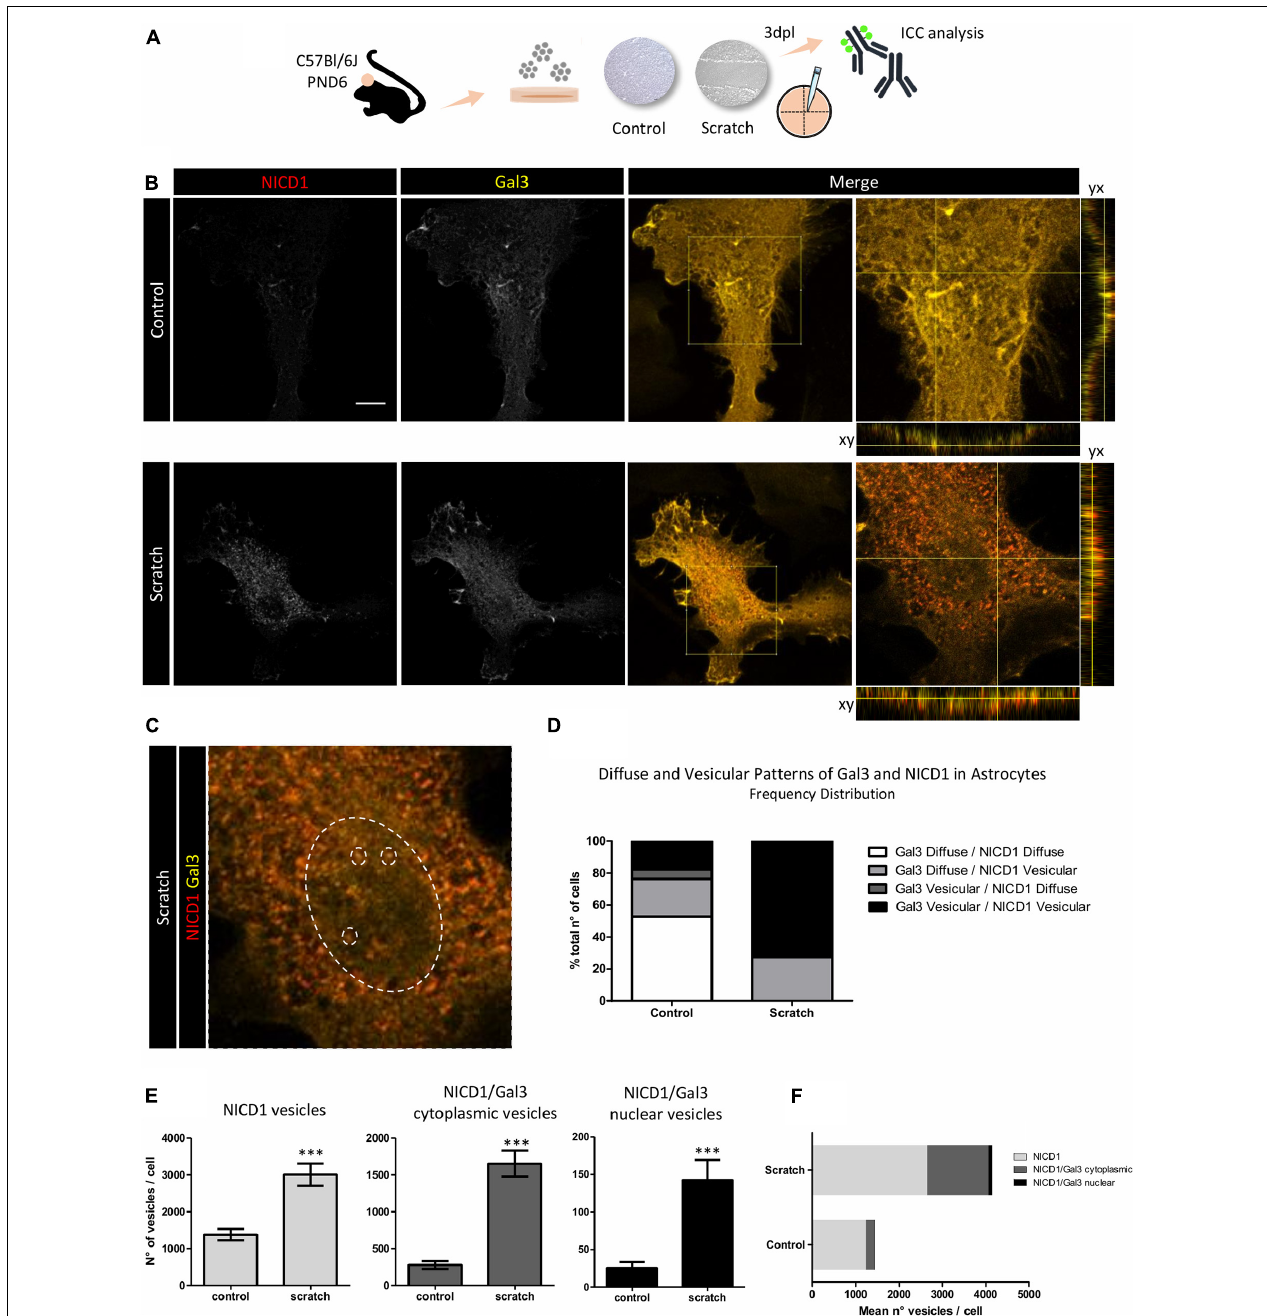
FIGURE 3 | NICD1 and Gal3 colocalize in vesicles in reactive astrocytes. (A) Experimental design: NICD1 and Gal3 were immunolabeled in scratch-reactivated and control (non-reactivated) astrocytes and analyzed by confocal microscopy. (B,left) Representative confocal Z-stack gray scale images of NICD1 and Gal3 in control and reactive astrocytes. (B,right) Merged images of NICD1 and Gal3 and detailed images with the orthogonal view of the immunostaining. Scale bar: 20 µ m. (C) Zoom image from one reactive astrocyte: large dashed circle indicates the nucleus and the three small dashed circles inside the large circle indicate representative vesicles, highlighting NICD1 and Gal3 intranuclear colocalization. (D) Frequency analysis of NICD1 and Gal3 immunolabeling patterns (diffuse and vesicular) in control and reactive astrocytes. Values are plotted as percentage of total number of cells analyzed: 52.9% control astrocytes showed Gal3/NICD1 diffuse pattern; 23.5% Gal3 diffuse/NICD1 vesicular; 5.9% Gal3 vesicular/NICD1 diffuse, and 17.6% Gal3 vesicular/NICD1 vesicular. Reactive astrocytes showed 27.3% Gal3 diffuse/NICD1 vesicular pattern and 72.7% Gal3 vesicular/NICD1 vesicular (control n = 17 cells, scratch n = 22 cells). (E) Quantification analysis of NICD1 + and NICD1 + Gal3 + vesicles revealed a higher number of NICD1 + vesicles, NICD1 + Gal3 + cytoplasmic vesicles and NICD1 + Gal3 + nuclear vesicles in reactive astrocytes compared to control. (*** p ≤ 0.001; unpaired Student’s t -test; control n = 18 cells, scratch n = 27 cells). (F) Graphical representation of mean number of NICD1 + , NICD1 + Gal3 + cytoplasmic and nuclear vesicles per cell in control and reactive astrocytes. (control n = 18 cells, scratch n = 27 cells).